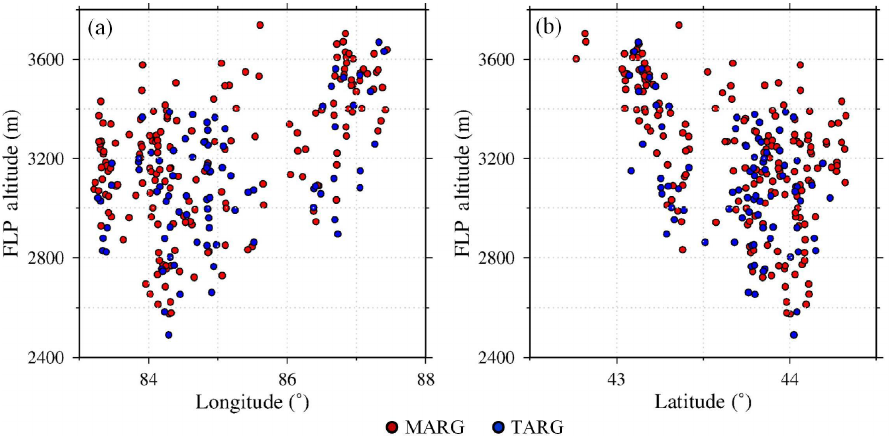
Figure 7. Scatter plots between the FLP altitudes and (a) the longitude and (b)